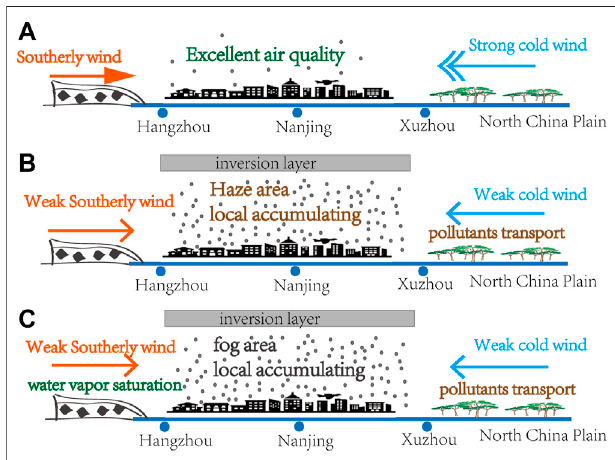
FIGURE 9 | Atmospheric BL conceptual model for the Jianghuai area. (A) Excellent air quality due to the southerly wind or the strong cold air; (B) haze and heavy pollution due to both the weak cold air and southerly wind; and (C) fog and heavy air pollution due to both the weak cold air and southerly wind (the scale with the city name represents the distance between the cities on the red line in Figure 1 ).